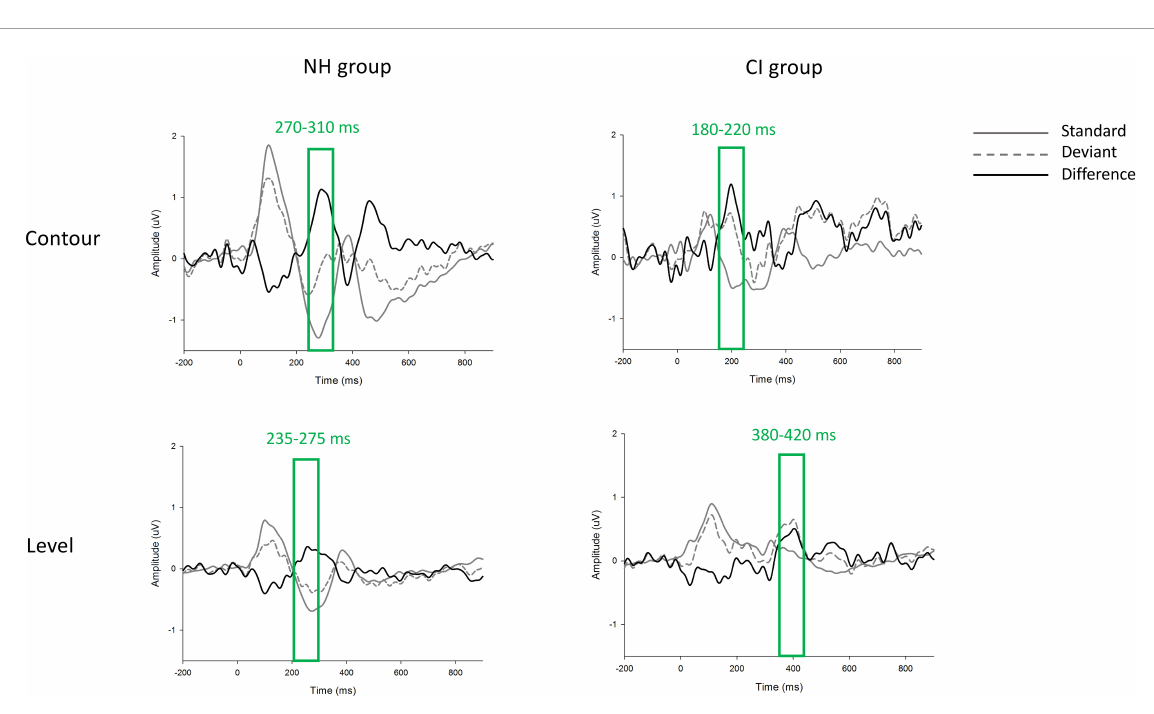
FIGURE4 The grand-averaged waveforms elicited by standard (gray solid line) and deviant (gray dashed line) stimuli at electrode FCz. The difference wave, i.e., positive mismatch responses (p-MMRs), were shown in black solid line. Time windows in each condition and each group were marked with